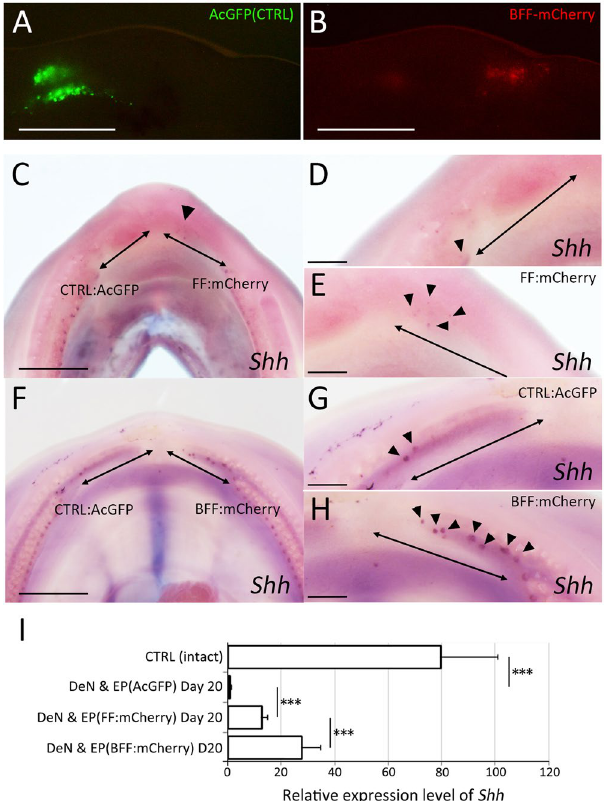
Figure 9. Induction of tooth regeneration by exogenous Fgf2 + Fgf8 + Bmp7. ( A,B ) Dark field views. Scale bars are 3 mm. ( A ) The control plasmids (AcGFP) were electroporated into the left side. ( B ) The Fgf8 + Fgf2 + Bmp7 + mCherry plasmids (BFF-mCherry) were electroporated into the right side. ( C–H ) Shh expression was restored on the side where Fgf2 + Fgf8 + mCherry (FF-mCherry; n = 10, C – E ) or BFF-mCherry (n = 13, F–H) was electroporated. D and E are higher magnification views of the left and right sides of C, respectively. G and H are higher magnification views of the left and right sides of F, respectively. Arrows indicate the dentectomized region and arrowheads indicate Shh expression. Scale bars in C and F are 3 mm. Scale bars in D, E, G, and H are 1 mm. ( J ) Quantitative RT-PCR analysis was performed on the samples 20 days after dentectomy and denervation. The expression level of Shh was confirmed in 5 samples. Statistical analysis was performed with the t -test (one tailed). *** p < 0.01.